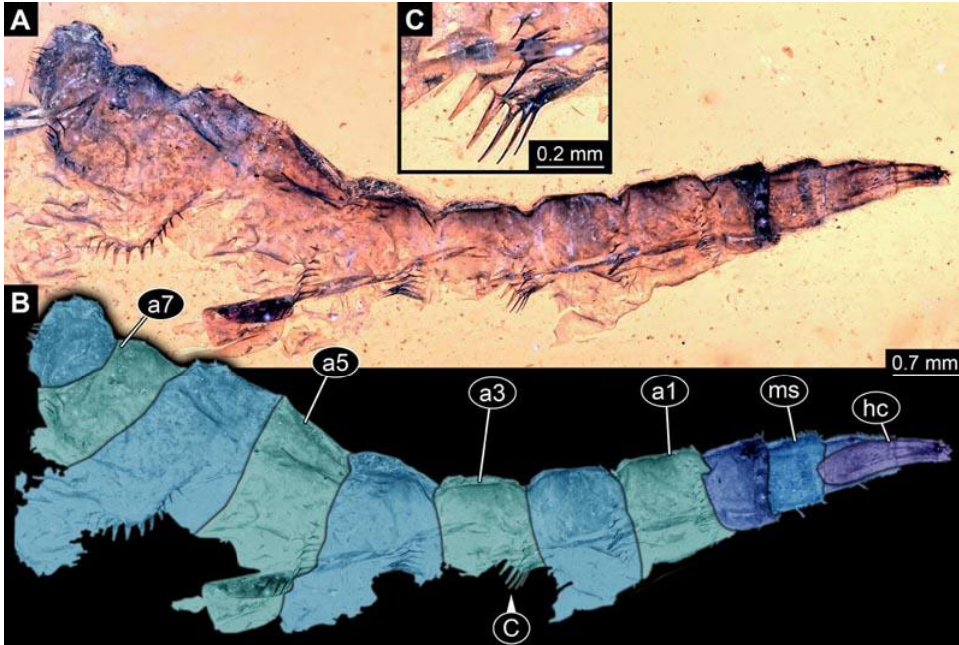
Figure 4. Fossil larva of morphotype 1, specimen PED 0701. ( A ). Lateral view. ( B ). Colour-marked. ( C ). Close-up of ventral spine-like setae. Abbreviations: a1–a7 = abdomen units 1–7; hc = head capsule; ms = mesothorax. Diversity 2023 , 13 , x FOR PEER REVIEW (4) PED 1200-4: Specimen relatively straight, slightly damaged on lateral side of ab- domen segment 5 (Figure 5). Surface structure apparent (Figure 5D). Head capsule well preserved (Figure 5C). Two rows of short, spine-like setae per segment of abdomen on ventral and dorsal sides (Figure 5D). Paired spiracle visible on trunk end. Dimensions: body length 1.3 mm, body width 0.77 mm, head capsule length 0.28 mm, head capsule width 0.13 mm.